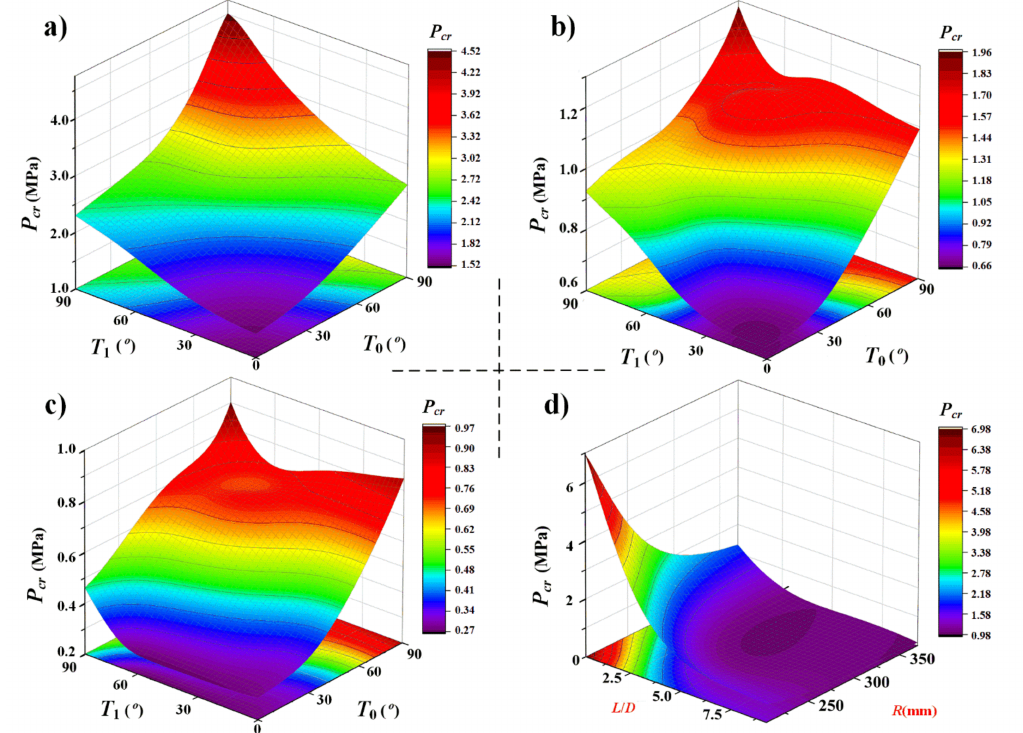
Figure 10. Contour maps of variables distribution with critical buckling pressure P cr for surrogate model built with different parameters of a VS cylindrical shell: ( a ) T 0 , T 1 , and response P cr with R = 200 mm, L / D = 2; ( b ) T 0 , T 1 , and response P cr with R = 250 mm, L / D = 3; ( c ) T 0 , T 1 , and response P cr with R = 300 mm, L / D = 4; and ( d ) L / D , R , and response P cr with T 0 = 45 ◦ , T 1 = 60 ◦